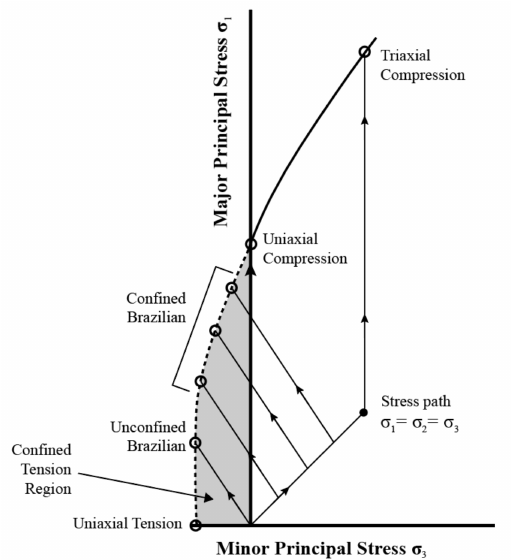
Figure 1. Failure curve in principal stress ( σ 1 – σ 3 ) space. The confined tension region is shown as a shaded area. The stress paths of different strength tests are shown, including the stress path followed by 3 confined Brazilian tests conducted under 3 different confining stresses. Figure modified from Patel and Martin